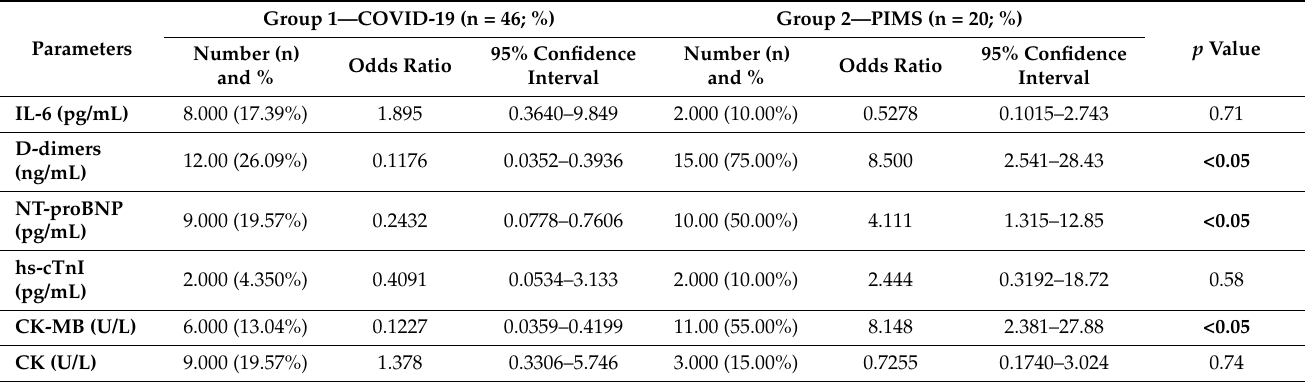
Table 4. The comparison between the inflammatory